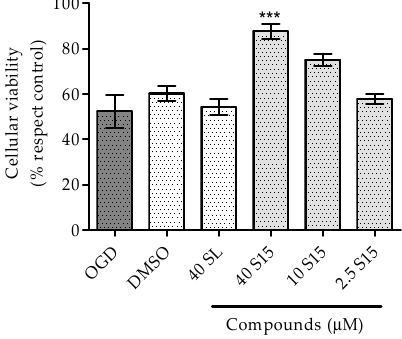
Figure 2. Neuroprotective activity of compounds against cell damage induced by chemical hypoxia and glucose deprivation. PC12 cells were cultured in oxygen and glucose deprivation conditions (OGD), specifically in the absence of glucose and in the presence of 600 µM of potassium cyanide (KCN) for 1 h, and then, normal culture medium was reperfused to the cells. After 4 h of the reperfusion start, some PC12 cells were treated with solvent control (DMSO), solasodine (SL) or different concentrations of the S15 derivative. After 20 h of exposition to the reperfusion damage and treatment, cellular viability was determined by the MTT assay. Data are represented as the percent with respect to the untreated cells, representing the highest cell viability. Asterisks indicate statistical differences between the treatment and respective control condition (*** p < 0.001) according to one-way ANOVA and Tukey’s post-hoc